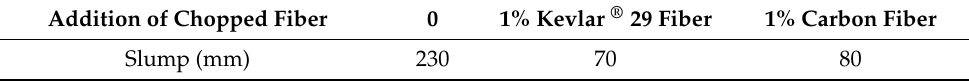
Table 3. Slump values of benchmark and FRC with 1% weight